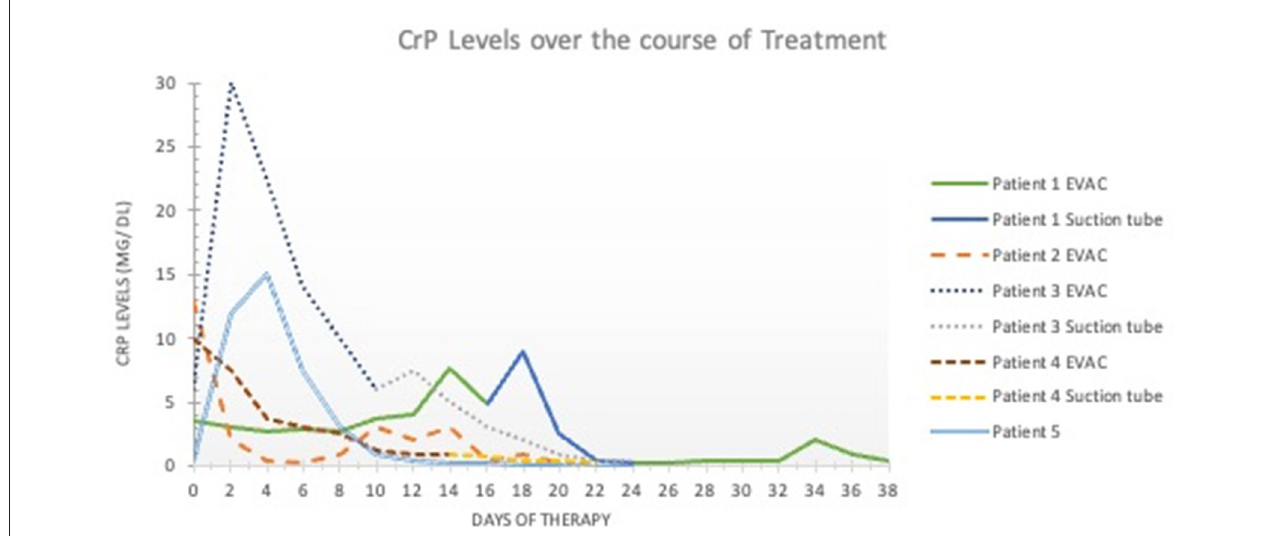
FIGURE 2 | C-reactive protein levels over time. The x- axis shows the duration of esophageal perforation therapy (in days). The y-axis shows the C-reactive protein levels in milligrams per deciliter (mg/dL). Values < 0.5 mg/dL are considered normal and without inflammation. EVAC, endoscopic esophageal vacuum-assisted closure; CRP, C-reactive protein.